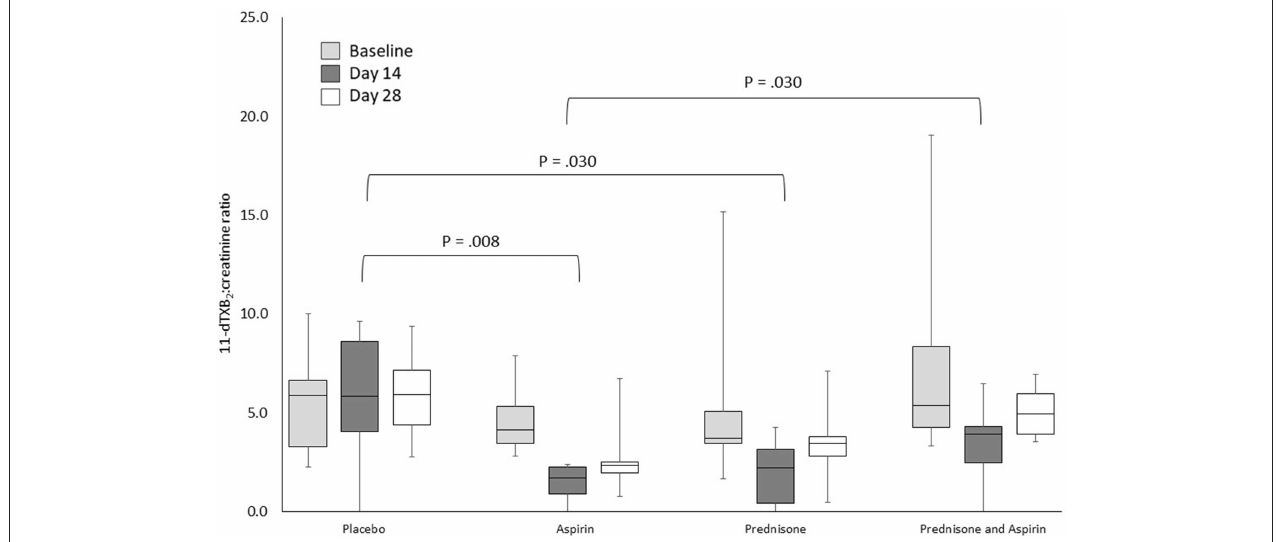
FIGURE 2 | Urine 11-dTXB 2 :creatinine ratios for 24 healthy dogs administered placebo, aspirin with placebo, prednisone with placebo, or combination prednisone and aspirin therapy for 28 days. Ratios differed significantly by treatment group ( P = 0.024) and sampling time ( P < 0.001), but not treatment-by-time. The brackets indicate the significant differences between treatment groups. The box and whiskers plot demonstrate the median (line), interquartile range (box), and total range (whiskers).